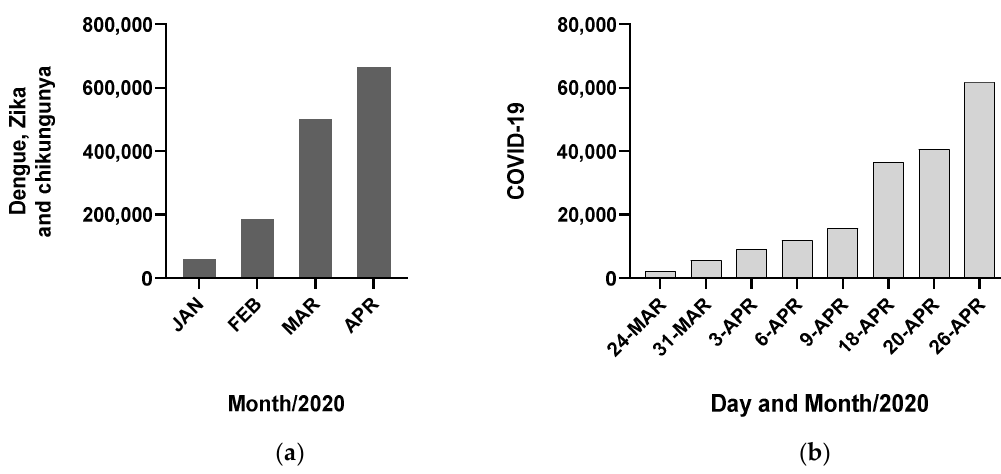
Figure 2. Cumulative notified cases of dengue, Zika and chikungunya ( a ) and COVID-19 ( b ) in Brazil as of April 2020.